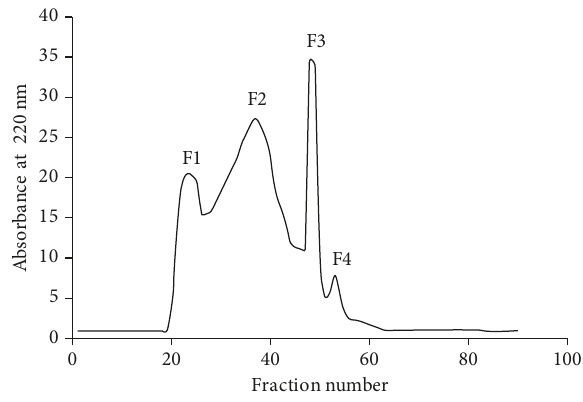
Figure 3: Elution profiles of CSPH separated by gel filtration chromatography on a Sephadex G-25 column. (Column size: Φ 1.6 × 100cm; flow rate: 0.3mL/min; elution solution: deionized